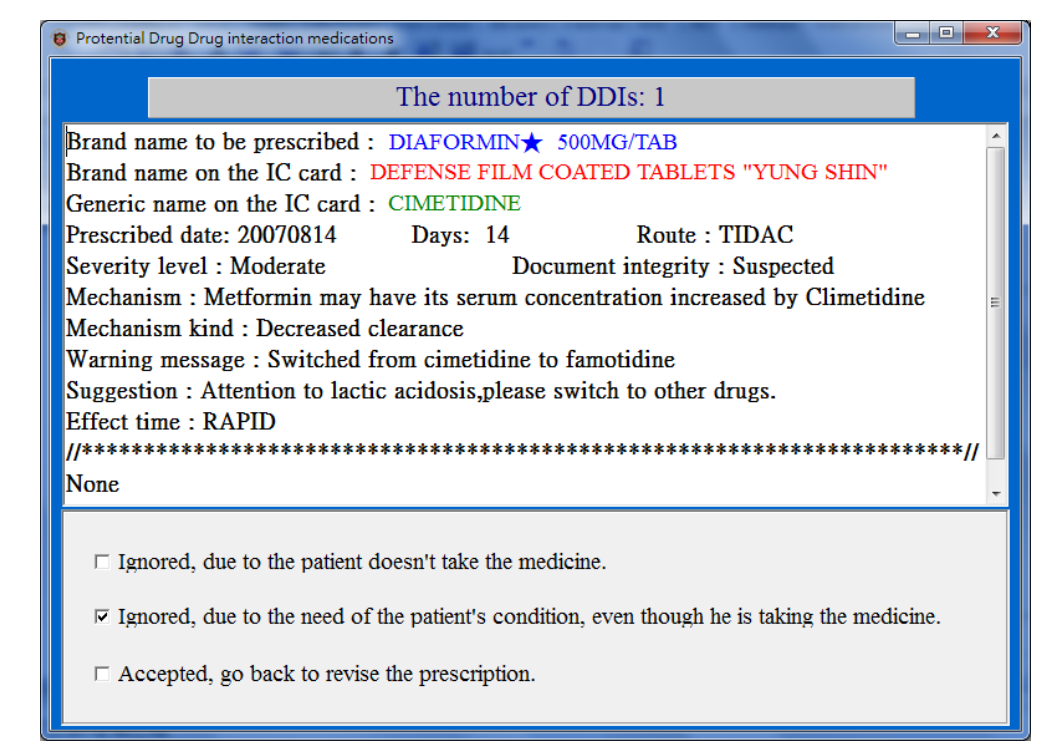
Figure 3. A popup screen (translated from Chinese) showing potential DDIs when